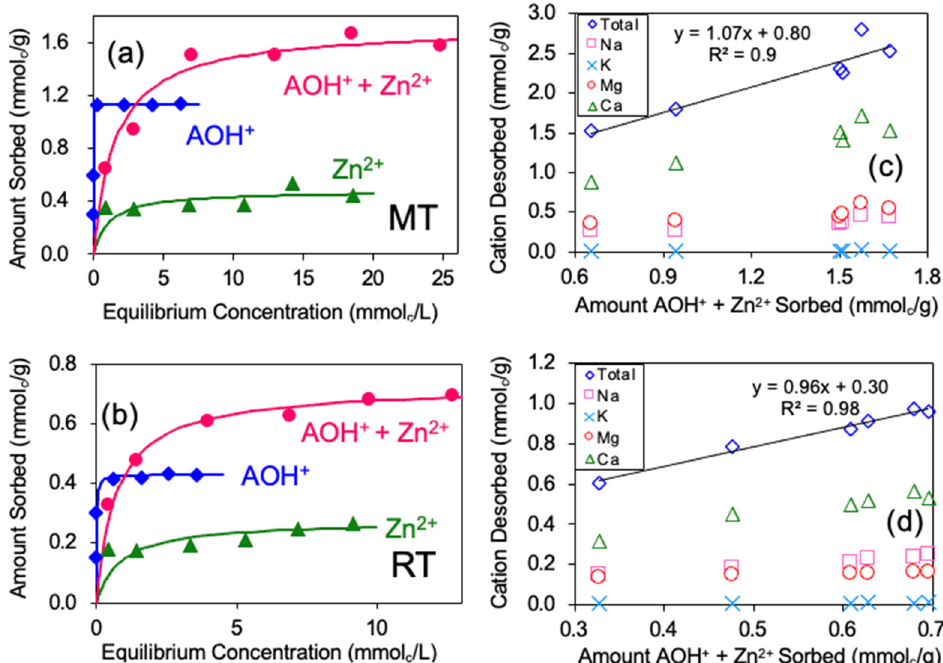
Figure 3. Sorption isotherms of AO on MT( a ) and RT ( b ), and the desorption of exchangeable cations from MT ( c ) and RT ( d ) accompanying AO sorption. As the molarity of Zn to AO was 1:1 in solution and Zn has a charge of 2+, the Zn 2+ sorbed and total AO + Zn 2+ sorbed are also plotted in these figures to show the stoichiometric of cation exchange.